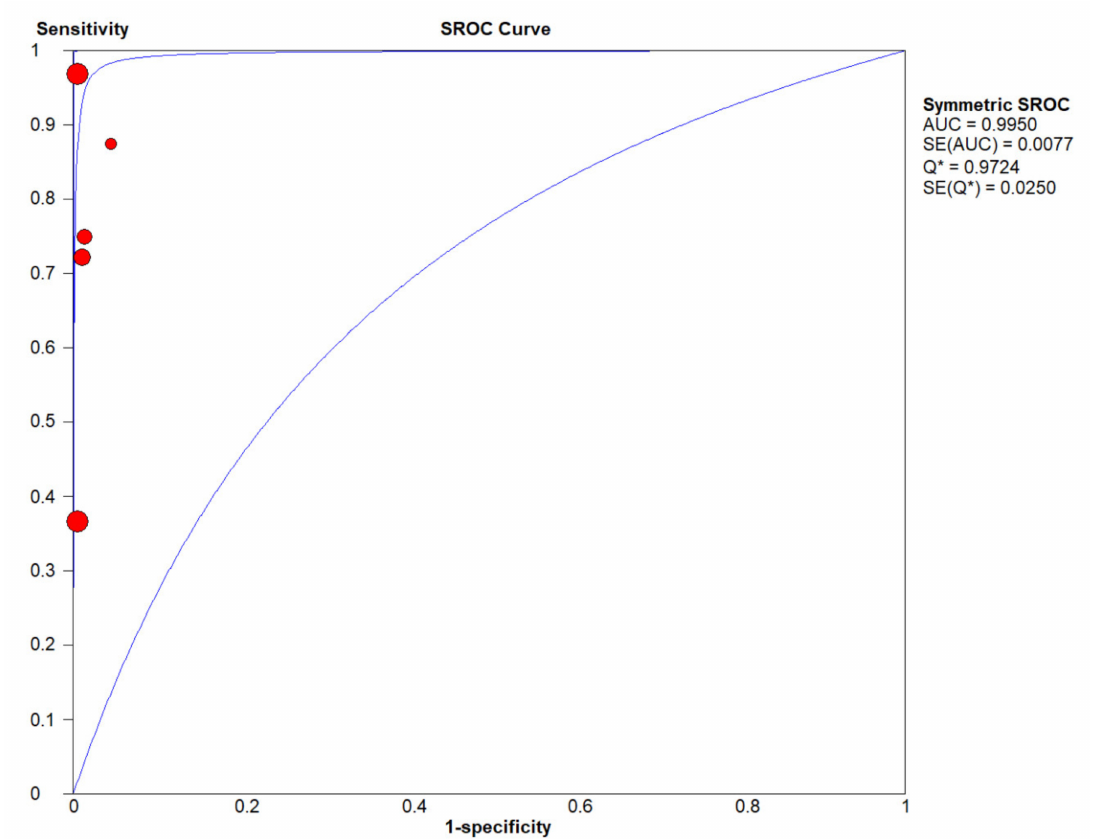
Figure 7. The summary receiver operating characteristic (SROC) curve for detection of cfHPV-DNA as a recurrence marker in HPV-related OPSCC. Blue lines represent the SROC curve and standard error (SE). The point where the SROC curve intersects the diagonal and sensitivity equals specificity is defined as Q*. Sensitive versus 1-specificity of each study is plotted as a red dot, whereas the size of the dot represents the sample size of the study cohort. (** studies included in meta-analysis during